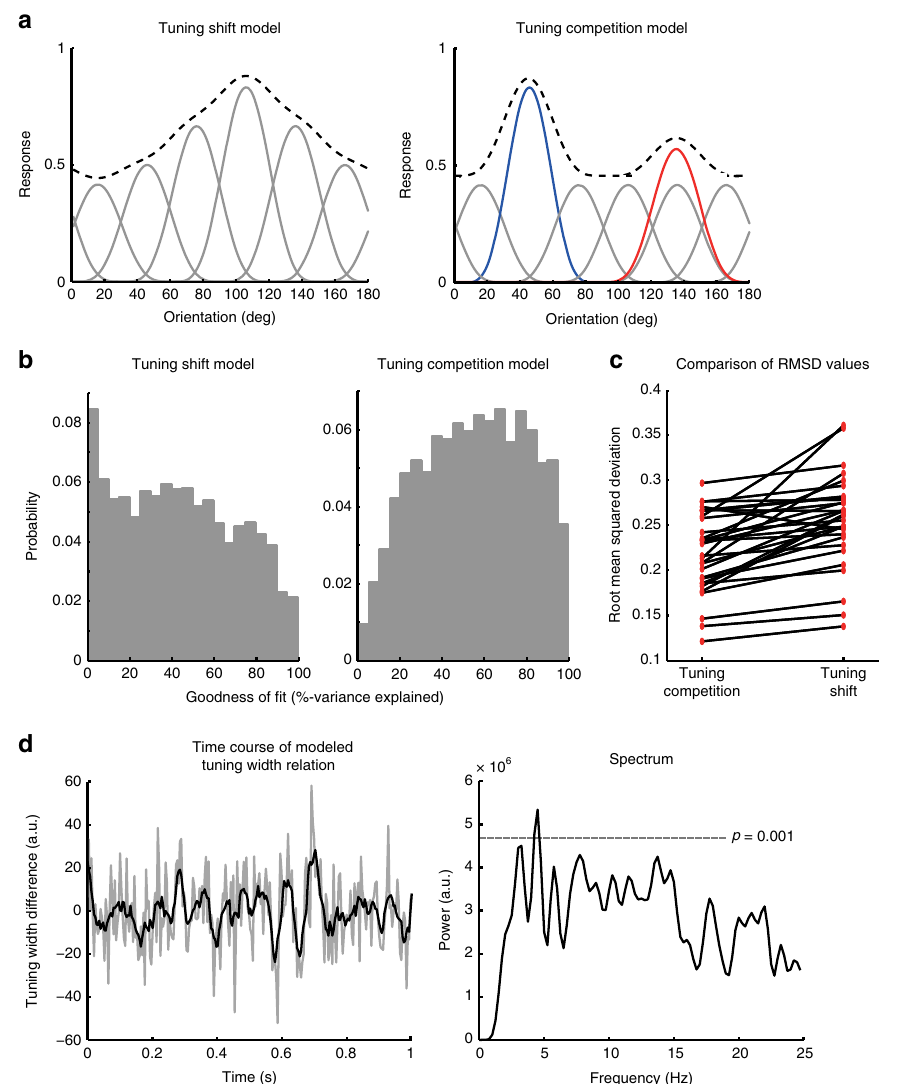
Fig. 3 Results of computational modeling. a Illustration of the tuning shift (TS) model (Left) and the tuning competition (TC) model (Right). The TS model postulates that attention shifts the tuning of individual neurons (gray curves) towards the attended feature, which results in a uni-modal population response pro fi le (black dashed curve) centered at the attended feature. In particular, when two features are attended, individual neuronal tunings would shift periodically between these two features in a similar manner, thus leading to a rhythmic oscillation of the population response pro fi le center. In contrast, the TC model postulates an ongoing competition between the neuronal populations tuned to the attended features (red and blue curves) in multi- feature attention while the other neurons remain little affected. This leads to a multi-modal population response pro fi le with local peaks at the attended features that rhythmically alternate in dominance. b , c Model comparison results. b Goodness-of- fi t (GoF) distributions across all time points pooled from all subjects. c RMSD values averaged across all time points plotted as paired red dots for individual subjects. d The modeled tuning width difference between the two neuronal populations plotted as a function of time (left) and its spectrum (right). The smoothed time course (in black) is overlaid on the unsmoothed time course (in gray). The gray dashed line denotes the statistical threshold for the spectrum (corrected for multiple